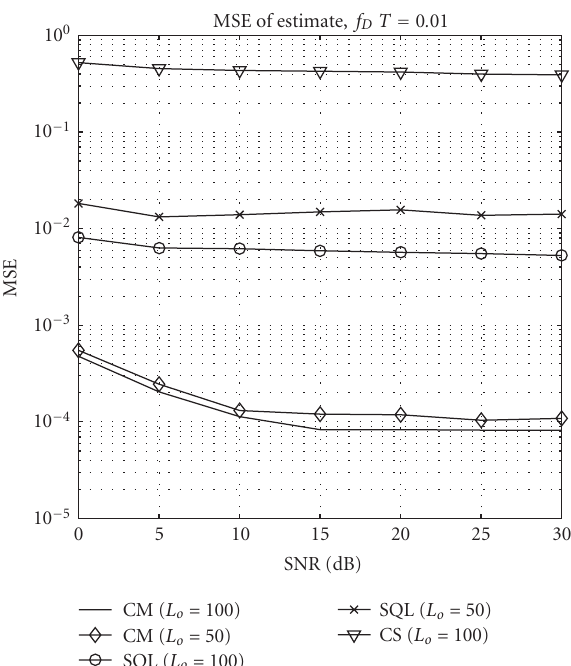
Figure 1: MSE versus SNR of proposed, CS and SQL algorithms for roll-o ff factor of